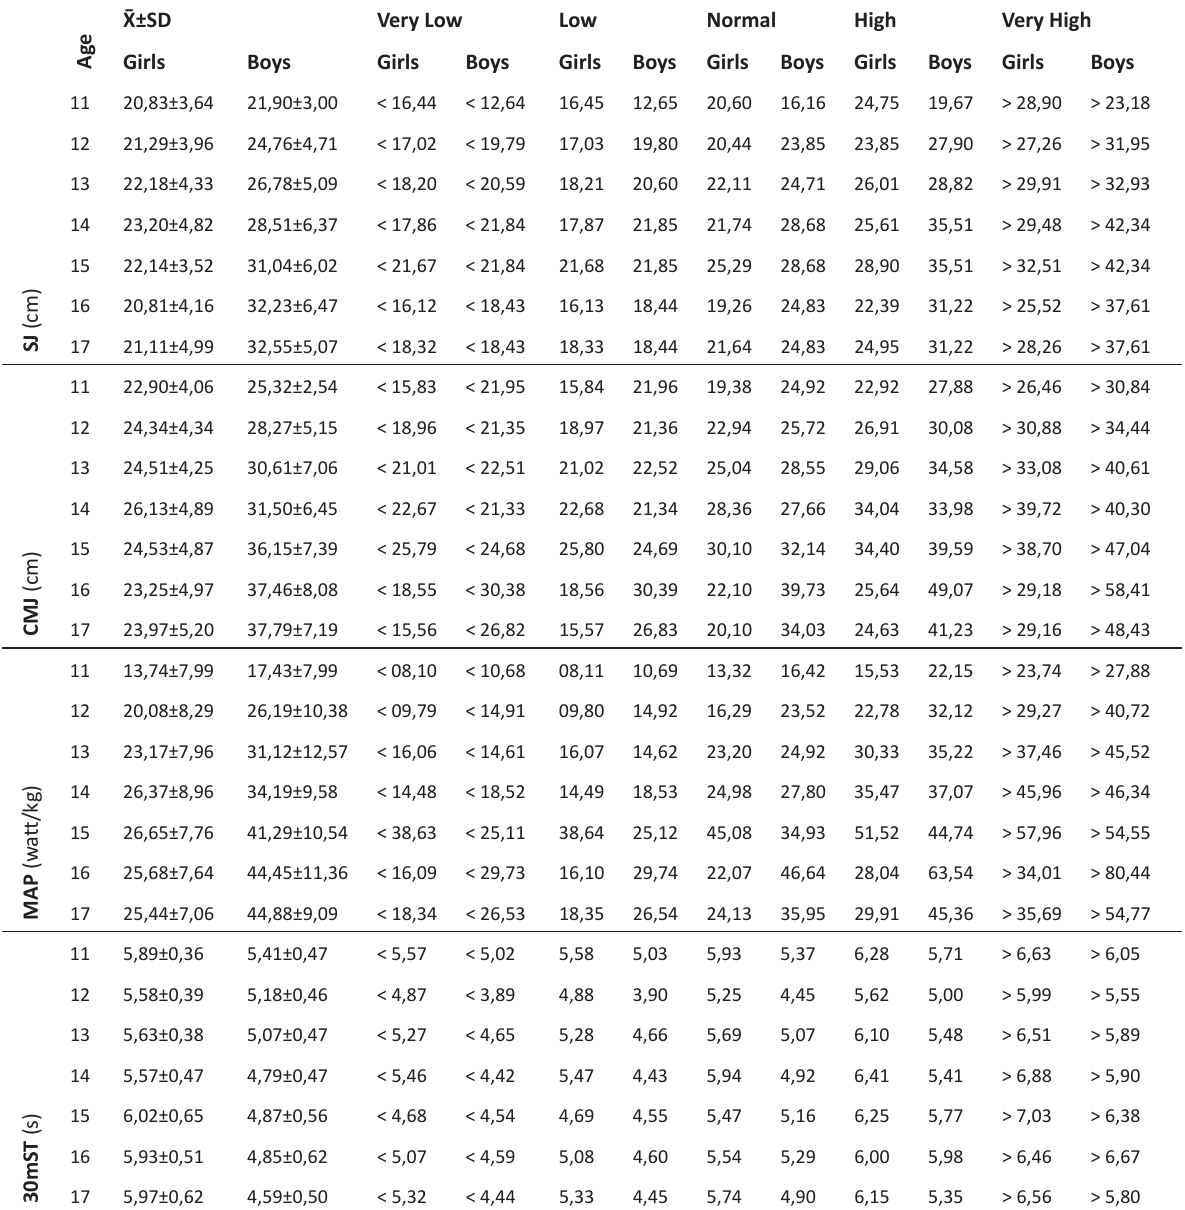
Table 5. Squat Jump, Countermovement Jump, Maximal Anaerobic Power, 30 – Meters Speed Test Normative Values